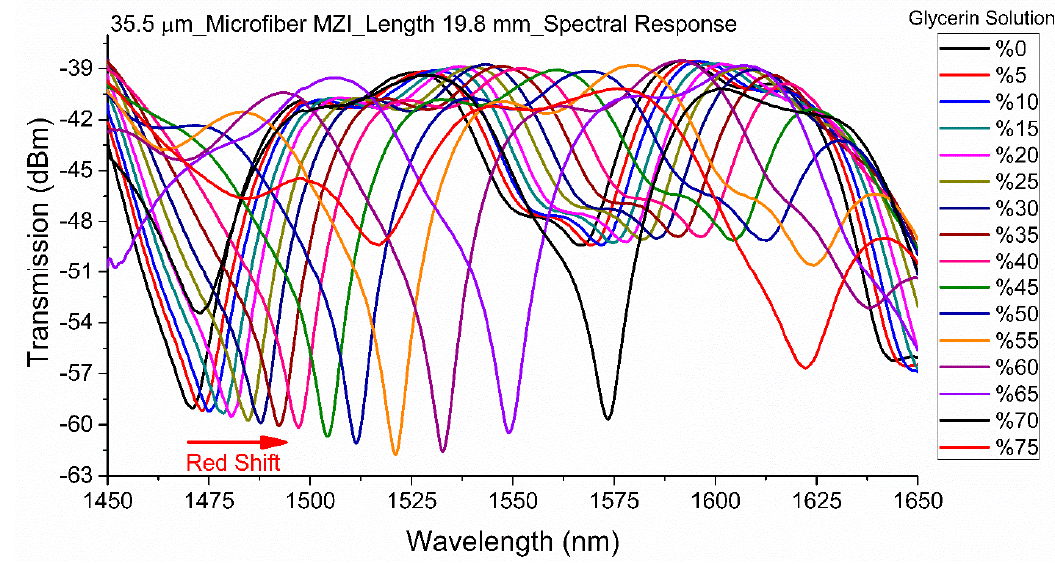
Figure 6. Spectral response of the MZI sensor with a 35.5 µm TWD to various concentrations of glycerin solution.